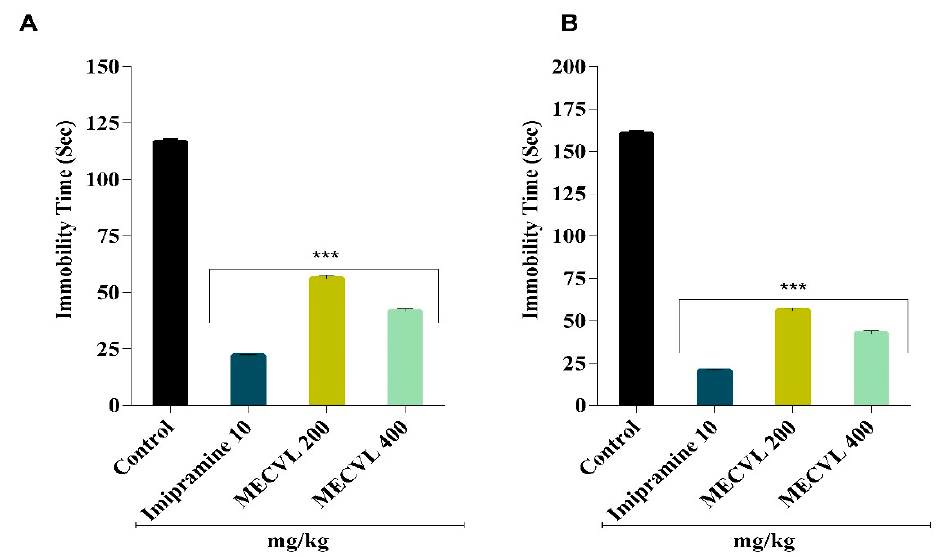
Figure 2. Effect of MECVL and imipramine in the force swimming test ( A ) and tail suspension test, ( B ) respectively. Each value is presented as the mean ± SEM (n = 5). *** p < 0.001 compared with the control group (Dunnett’s test); MECVL: Methanolic extract of Chukrasia velutina leaves.